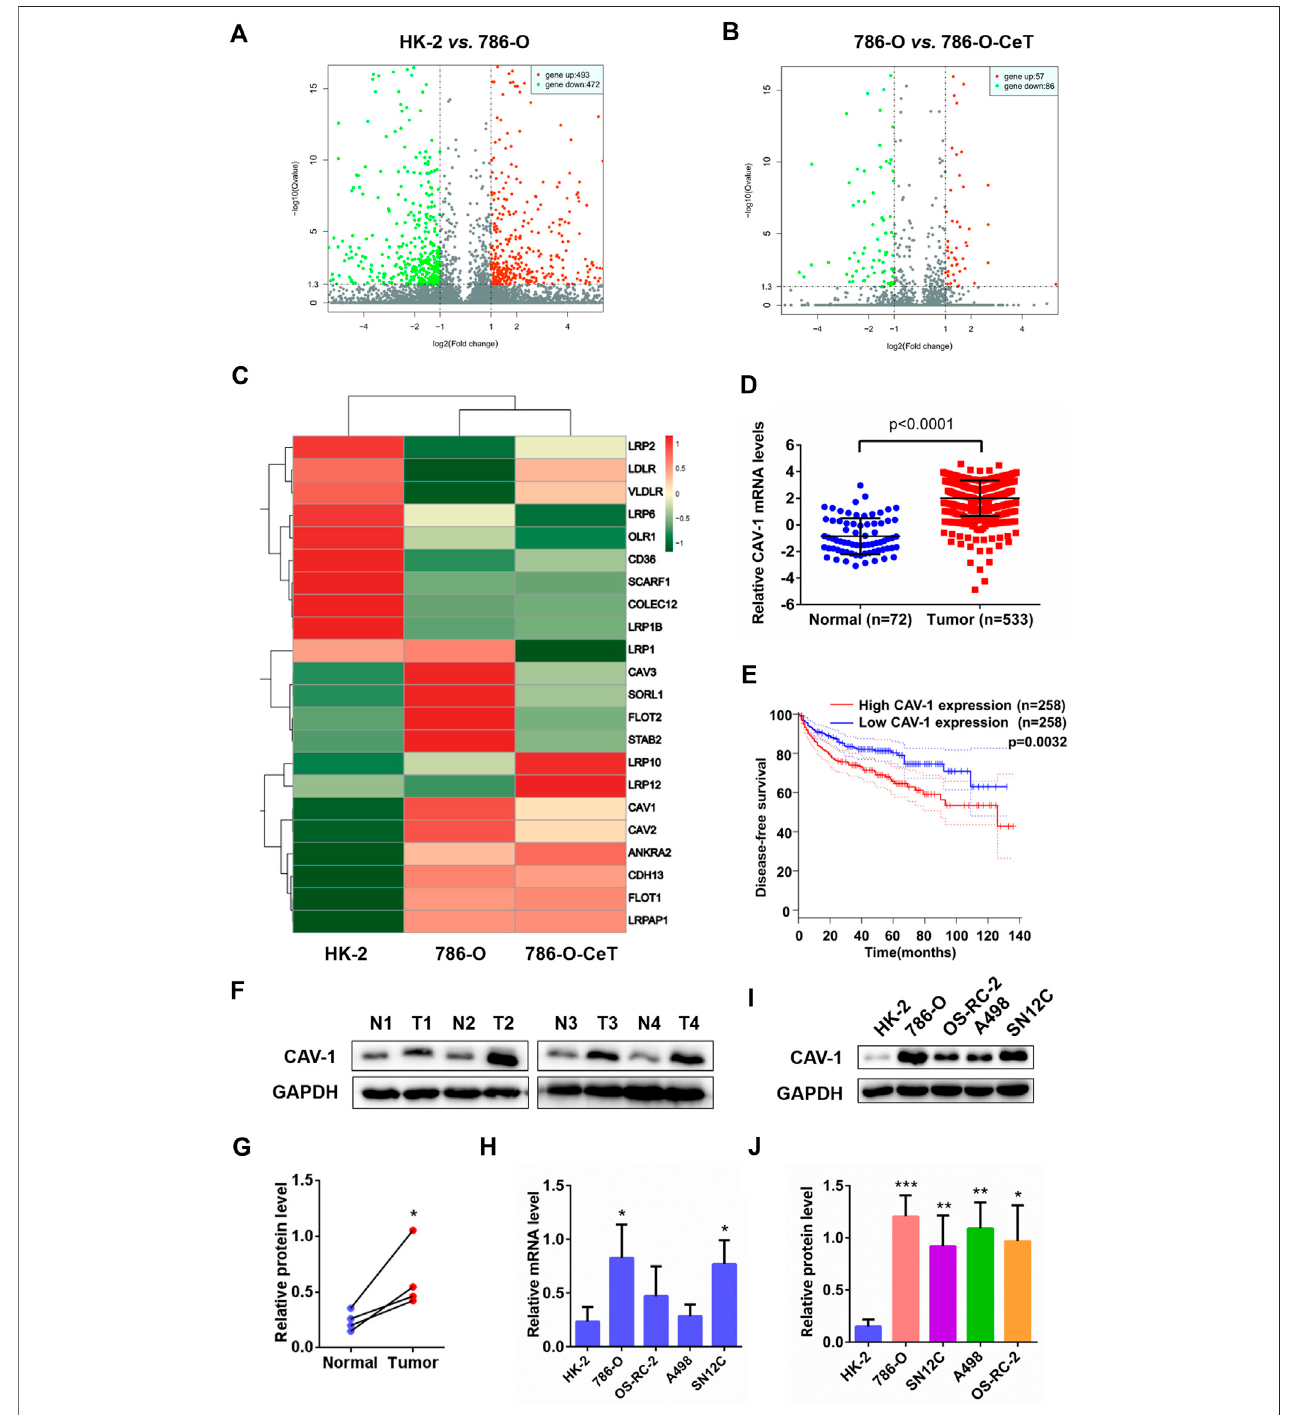
FIGURE 1 | Microarray analysis showed differentially expressed genes in regulating lipid uptake. CAV-1 was highly expressed in ccRCC tissues and cell lines (A) Volcano plot of p valuesas fold change for mRNAs in 786-O cells and HK-2 cells (B) The volcanoplot displayed different genesin celastrol (CeT)-treated 786-O cells vs. untreated 786-O cells. The x -axis was the log2 ratio of gene expression between two stages; the y -axis was adjusted the q value based on -log10. The red dots represented genes that were signi fi cantly upregulated, and green dots represented genes that were dramatically downregulated (C) Heat map of lipid uptake- related genes in HK-2 cells, untreated 786-O cells and CeT-treated 786-O cells (D) The mRNA level of CAV-1 was obtained from TCGA_KIRC datasets and GTEx datasets (E) ThecorrelationbetweenCAV-1expressionanddisease-freesurvivaltimeofccRCCpatientswasanalyzedbyKaplan-Meier (F,G) WesternblottingofCAV-1 expression inccRCC tissues (T)and adjacent tissues (N) (H – J) qRT-PCR analysisand western blottingwereused to detect themRNA and protein expression ofCAV-1 inHK-2cellsandccRCCcelllines(786-O,OS-RC-2,A498,SN12C).Thedatawereshownasthemean ± SDofthreereplicates.* p < 0.05, ** p < 0.01, *** p < 0.001vs.the corresponding